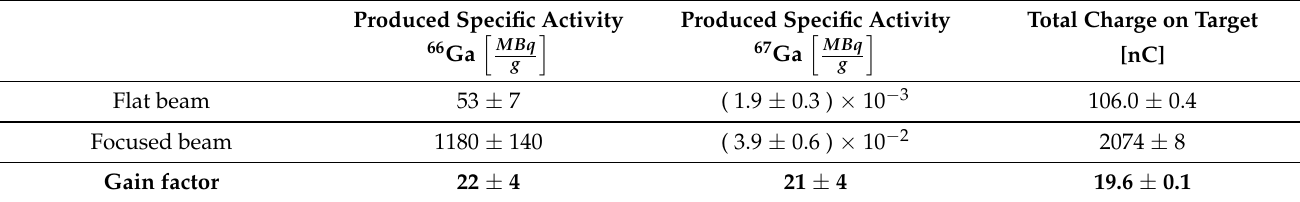
Table 1. Comparison of gallium production using natural zinc targets with a flat and an optimized beam. Produced Specific Activity Produced Specific